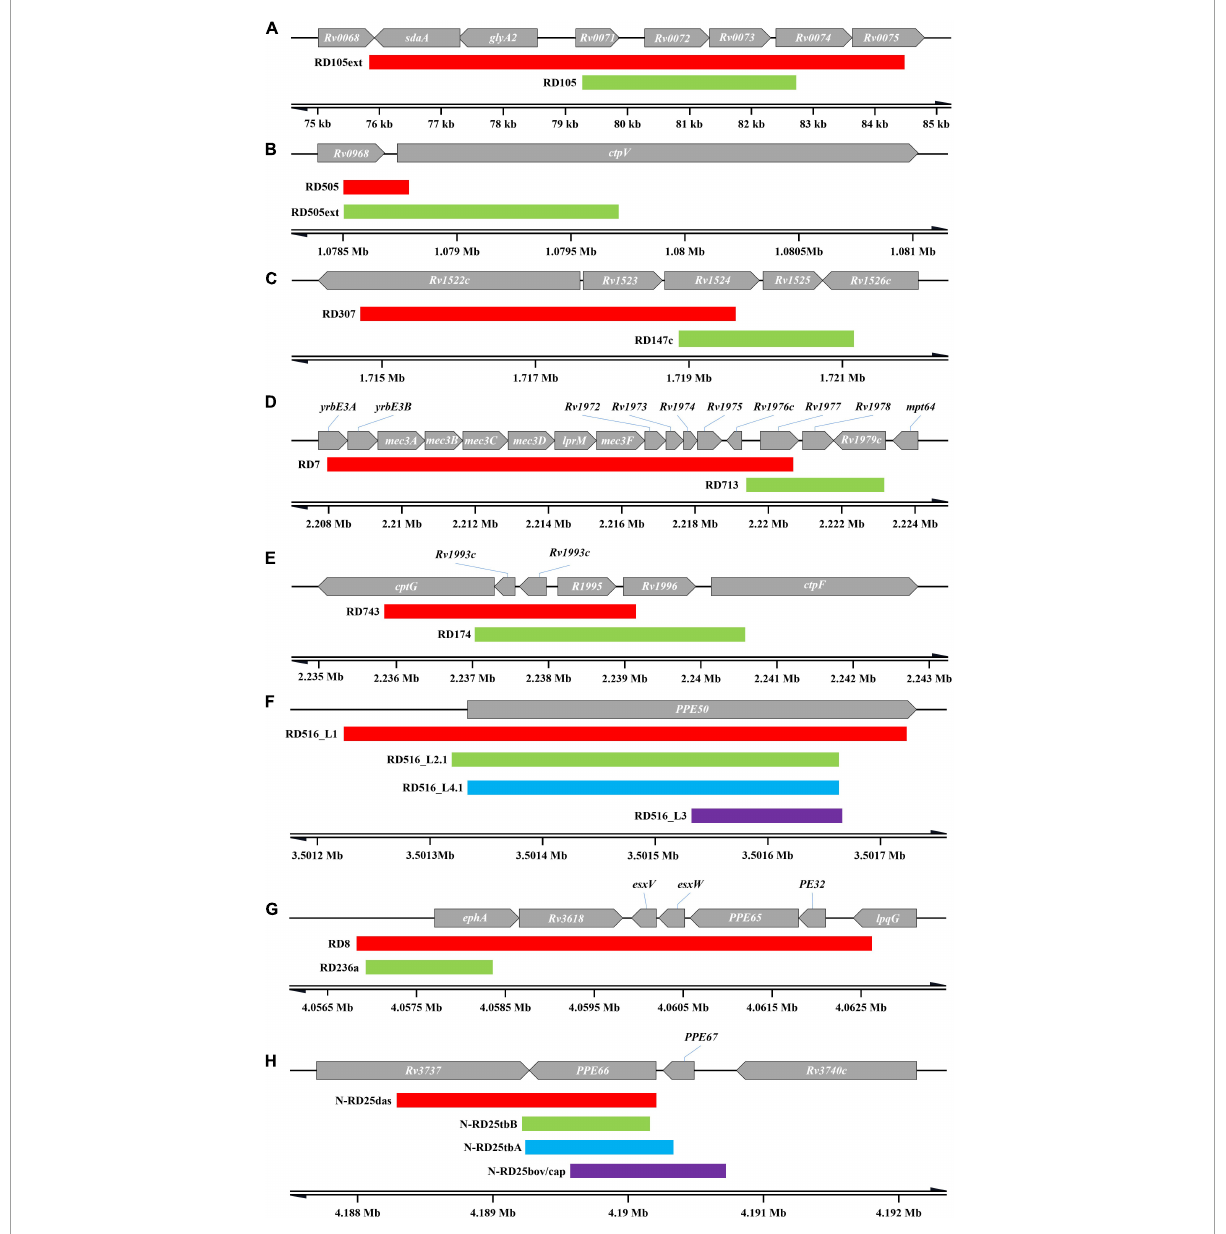
FIGURE4 Overlapping RDs. Only the RDs mentioned in the text are shown, and do not include RD317 and RD306, and the deletion in RD5 region and RD1 region. (A) RD105 and RD105ext. (B) RD505 and RD505ext. (C) RD307 and RD147c. (D) RD7 and RD713. (E) RD 743 and RD174. (F) RDs in RD516 region. (G) RD8 and RD236a. (H) RDs in N-RD25